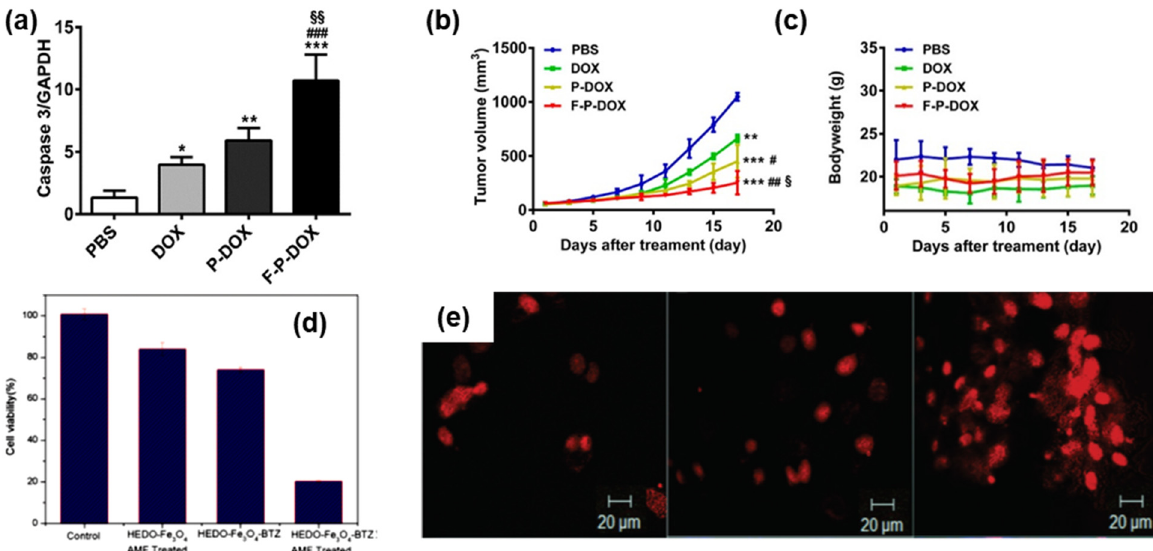
Figure 34. ( a ) The mRNA expression of Caspase 3, an apoptosis-associated gene, was examined via RT–PCR upon exposure to PBS buffer, free DOX, or IONPs integrated with poly( β -aminoester) (P-DOX) and folate (F-P-DOX). ( b ) Tumor growth curves and ( c ) body weight curves demonstrating the improved antitumor efficacy of F − P-DOX in a GC xenograft model, without obvious adverse effects. Each experiment was conducted in triplicate. *p < 0.05, **p < 0.01, ***p < 0.001 vs PBS group; #p < 0.05, ##p < 0.01, ###p < 0.001 vs DOX group; §p < 0.05, §§p < 0.01 vs P- DOX group. Reproduced with permission from reference [147]. Copyright 2015 American Chemical Society. ( d ) The in vitro anticancer effects of p(HEMA-co-DMA)-integrated IONPs loaded with BTZ (HEDO–Fe 3 O 4 –BTZ) on SCC7 cell lines. ( e ) Magic RedTM assay showing the apoptosis-inducing effect (red fluorescence) with hyperthermia alone (HEDO–Fe 3 O 4 , AMF on), chemotherapy alone (HEDO–Fe 3 O 4 –BTZ), and combined application of hyperthermia and chemotherapy (HEDO–Fe 3 O 4 –BTZ, AMF on). Adapted with permission from reference [149]. Copyright 2015 Royal Society of Chemistry.